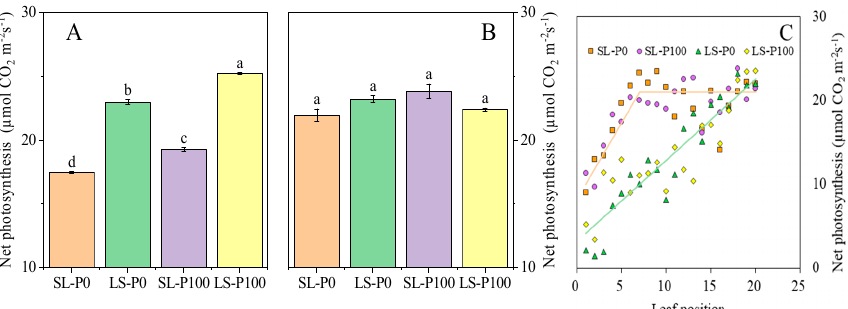
Figure 5. The e ff ect of P application and light condition on net photosynthesis of the youngest fully expanded leaf (( A ): V5 stage, ( B ): R3 stage) and ( C ) the whole plant Pn (Photosynthesis) was measured from the leaves situated lowest on the main stem to the highest (counted for 20 trifoliate leaves in soybean at R3 stage) in the pot experiment. Plants were grown in two light conditions (SL: shade from sowing to the V5 stage and from V5 to R8 under natural light condition; LS: from sowing to the V5 stage under natural light condition and shade from V5 to R8) and two P application treatments (P0 = without P application; P100 = 100 mg P kg − 1 soil application). Values represent the mean of three replicates ± SE. Di ff erent letters on the columns are used to indicate means that di ff er significantly by LSD ( p ≤